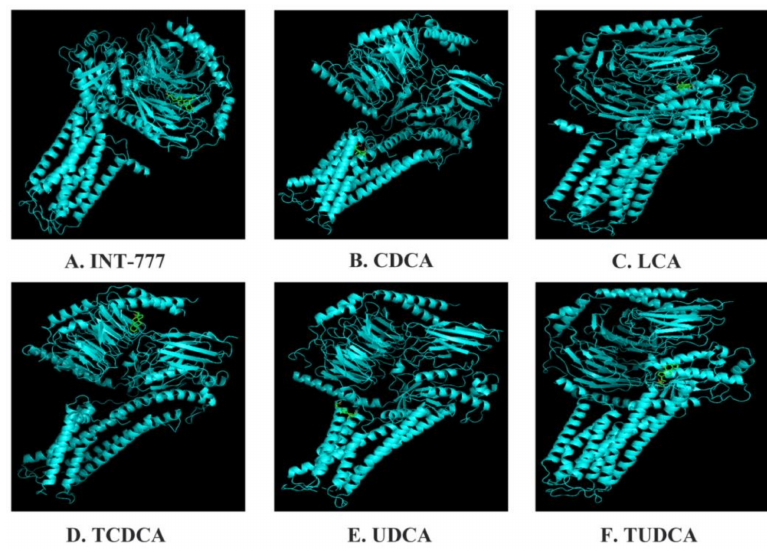
Figure 2. Molecular docking of TGR5 to bile